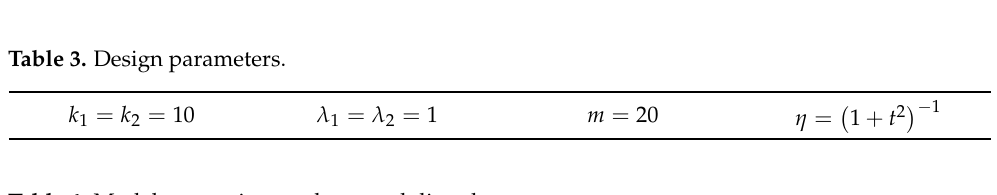
Table 4. Model uncertainty and external disturbance.